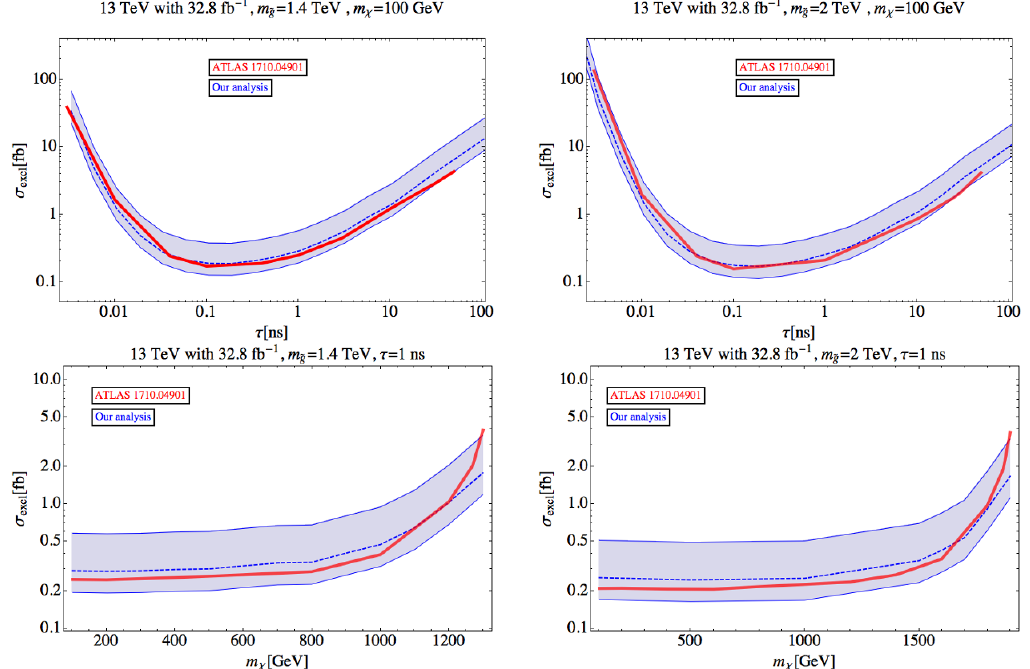
Figure 13 . Comparison between the result of our simulation and the excluded cross section reported in the ATLAS paper [53] for a long-lived gluino simpli(cid:12)ed model. The ATLAS results are shown as red lines, while our analysis corresponds to the blue bands. In order to draw our bands, we considered variation of the e(cid:14)ciency of (cid:6) 50%. The upper plots show the excluded cross section as a function of c(cid:28) for a (cid:12)xed neutralino mass m (cid:31) = 100 GeV and two benchmark values for the gluino mass, m = 1400 ; 2000 GeV. The lower plots show the excluded cross section as a function ~ g of m (cid:31) (cid:12)xing (cid:28) = 1 ns and the same two benchmarks for m . ~ g Recasting and